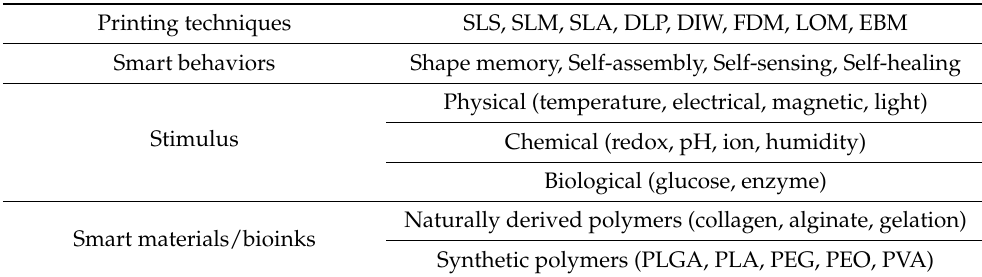
Table 1. Multiple classifications for 4D